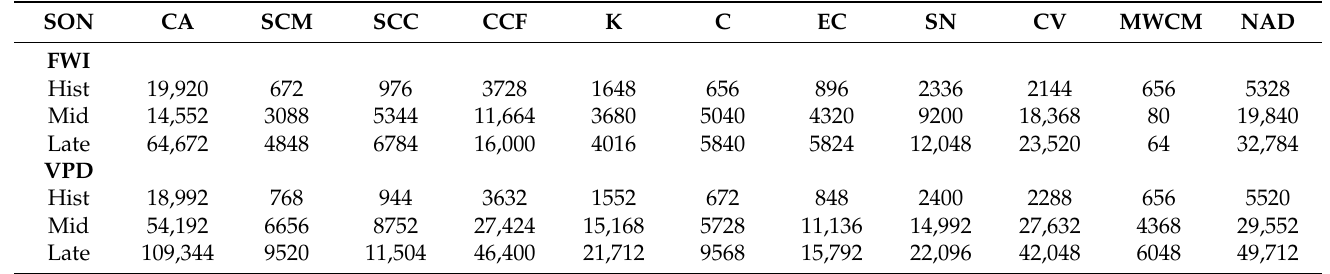
Table 3. The extent of each ecoregion experiencing SON FWI and VPD greater than the 95th percentile. Calculated from the ecoregion 30 year average. Units: km 2